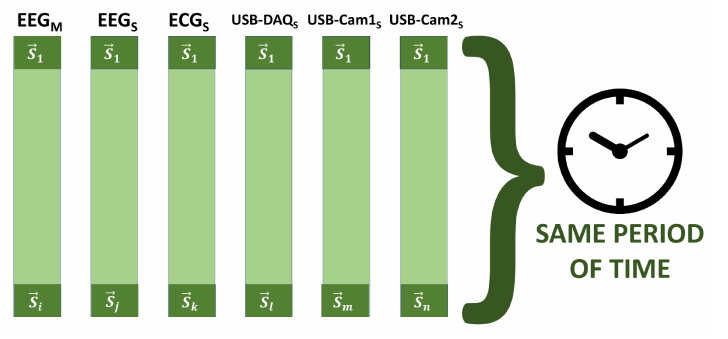
Figure 17. Sampling